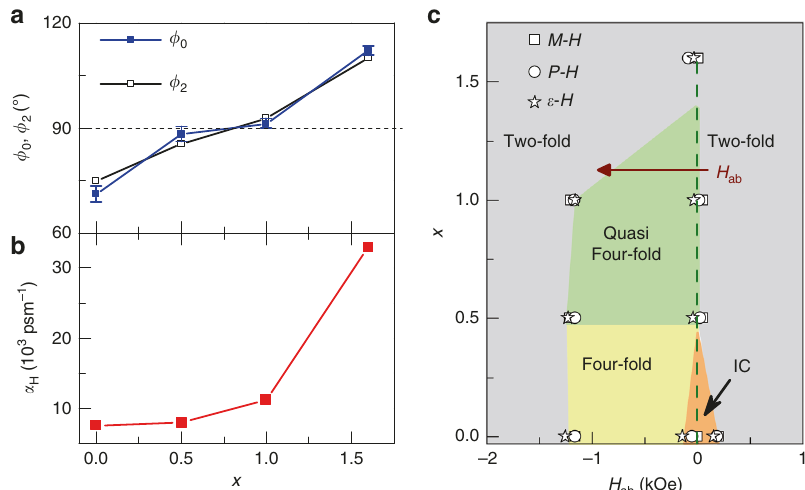
Fig. 5 Correlation between spin cone symmetry and the ME coef fi cients. Sr content dependence of a the angle ϕ 0 and ϕ 2 , and b the maximum value of α H . ϕ 0 is determined from the neutron diffraction data with the data. α H is derived from Fig. 2d. c The doping-dependent magnetic phase diagram of Ba 2- x Sr x Mg 2 Fe 12 O 22 in the low H ab region with the down sweep run. The phase boundaries are determined from the M-H , P-H and ε -H curves in Fig. 2, denoted by different